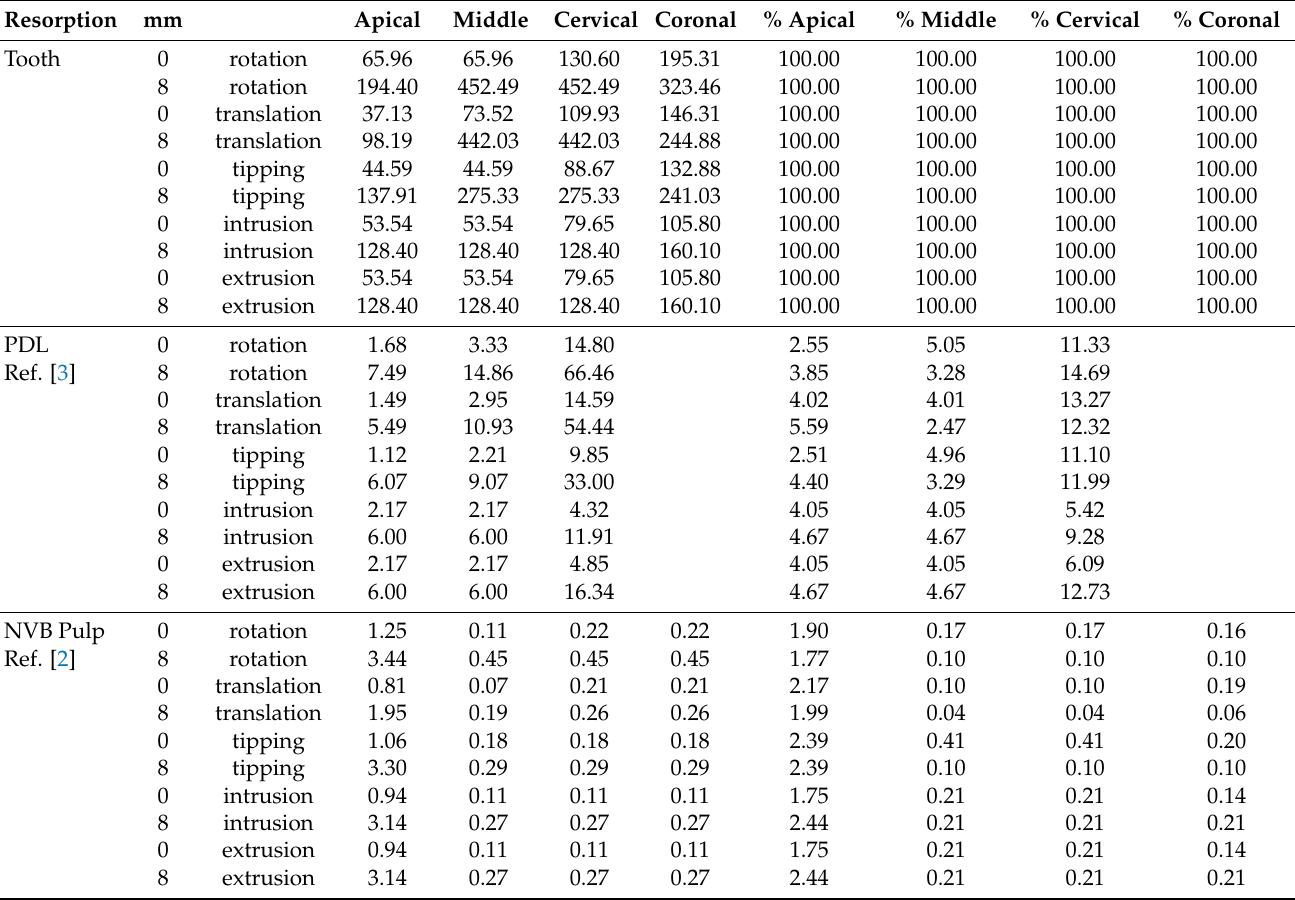
Table 4. VM criteria—maximum stress average values (KPa) produced by 0.5 N/50 g of force in tooth, PDL, NVB pulp, and % of the tooth quantitative stress that is displayed by the PDL, dental pulp and NVB